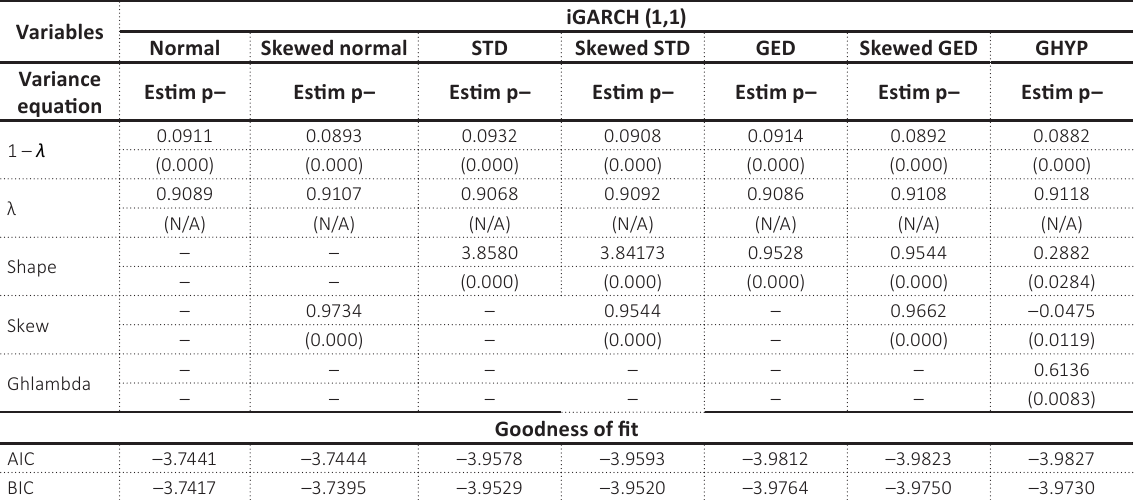
Table 3. Optimal RiskMetrics estimate parameters for